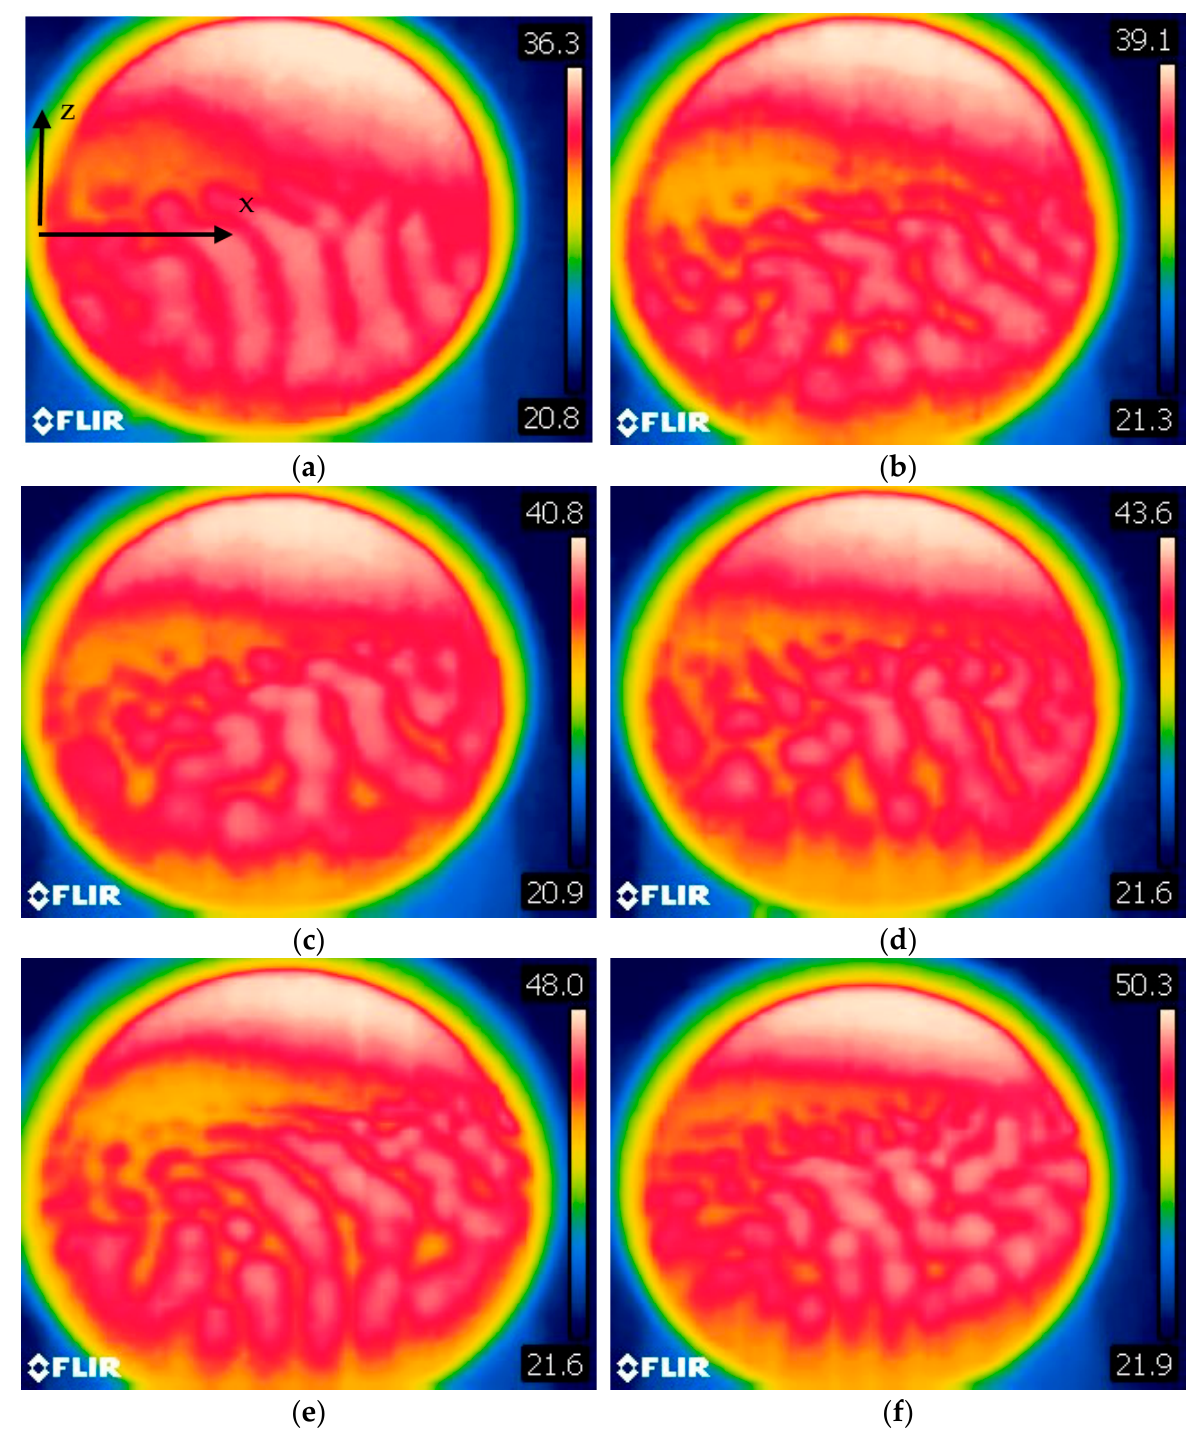
Figure 16. Surface temperature distribution for d = 0.50 cm ( Ω ≅ 70 mL) and ϑ ≅ 5° ( A = 26.6, Bo dyn ≅ 0.86, Ra ≅ 2.5 × 10 2 × ∆ T , Ma ≅ 2.94 × 10 2 × ∆ T ): ( a ) ∆ T = 15 °C, ( b ) ∆ T = 18 °C, ( c ) ∆ T = 21 °C, ( d ) ∆ T = 24 °C, ( e ) ∆ T = 27 °C, ( f ) ∆ T = 30 °C (the x and z axes correspond to the horizontal and vertical directions in all the panels).